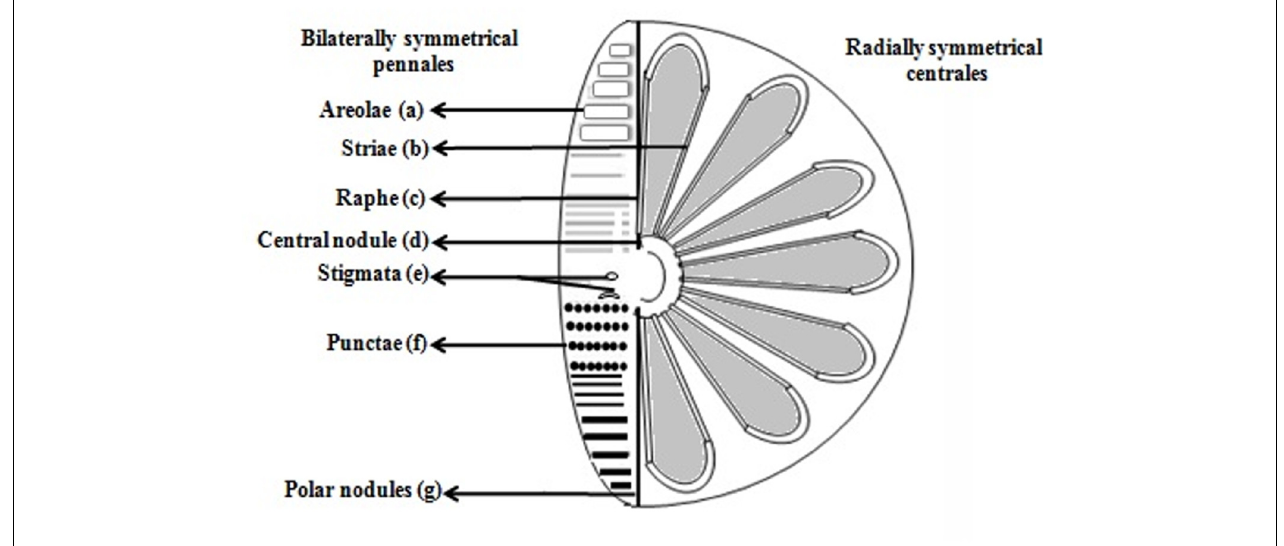
FIGURE 1 | The intricate structures of the diatom. Diatom encompasses (a). Areolae (hexagonal or polygonal boxlike perforation with a sieve present on the surface of diatom, b). Striae (pores, punctae, spots or dots in a line on the surface, c). Raphe (slit in the valves, d). Central nodule (thickening of wall at the midpoint of raphe, e). Stigmata (holes through valve surface which looks rounded externally but with a slit like internal, f). Punctae (spots or small perforations on the surface, g). Polar nodules (thickening of wall at the distal ends of the raphe) diagram modified from Taylor et al.